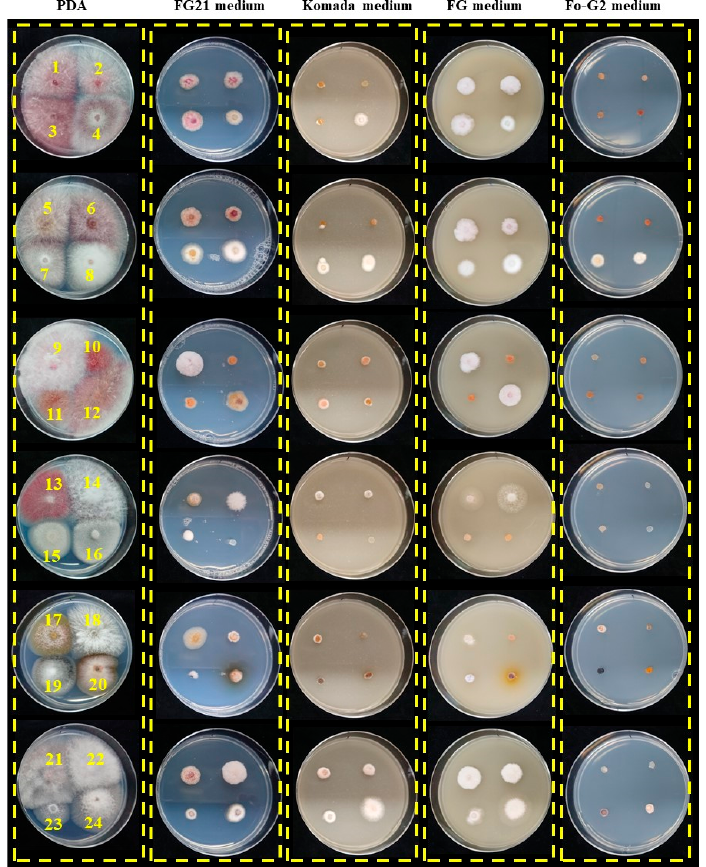
Figure 1. Fungal growth comparison of the FG21 medium and previously developed media. Potato dextrose agar (PDA) is a general medium for fungal culture and is used as the foundation of FG21 medium. Komada [16] and Fo-G2 [17] are Fusarium oxysporum selective media. FG is a Fusarium graminearum -selective medium [20]. The strains were cultured at 25 °C for 4 d. Fusarium graminearum sensu stricto Fg0101020 (1), Fg0201201 (2), Fusarium asiaticum Fa0244004 (3), Fa0239005 (4), Fusarium